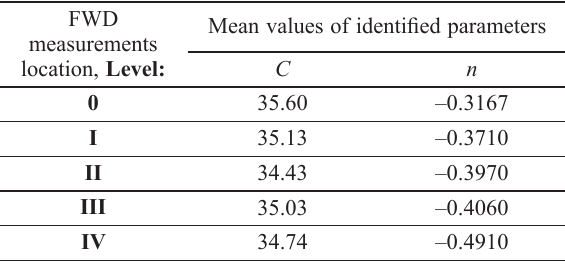
Fig. 6. The general path of analysis in proposed